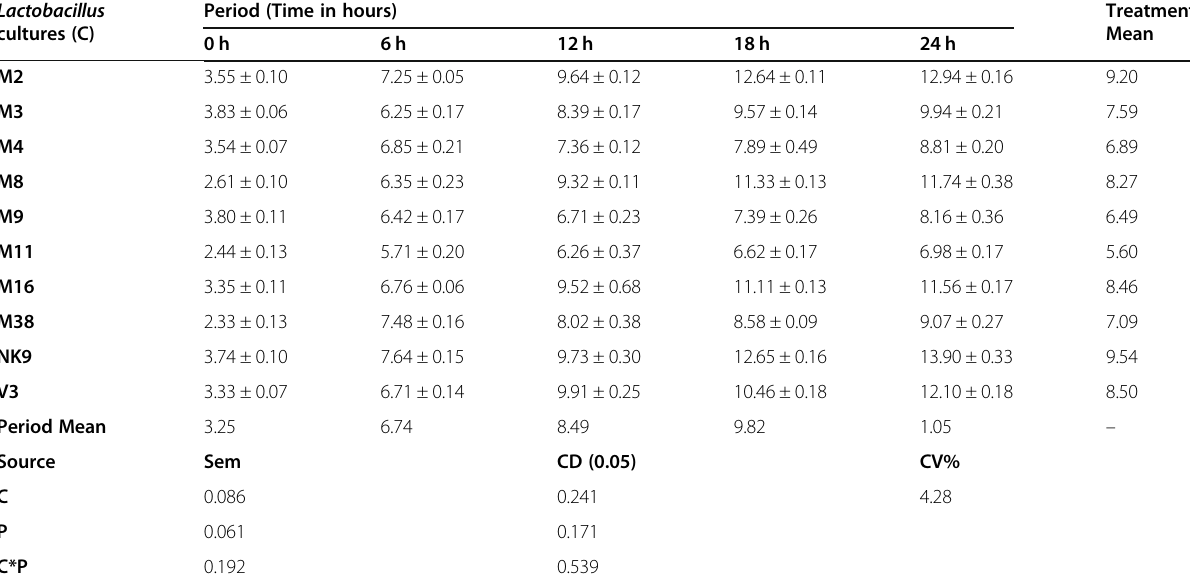
Table 1 α -galactosidase activity (U/mg) of Lactobacillus cultures in soy milk medium Lactobacillus cultures